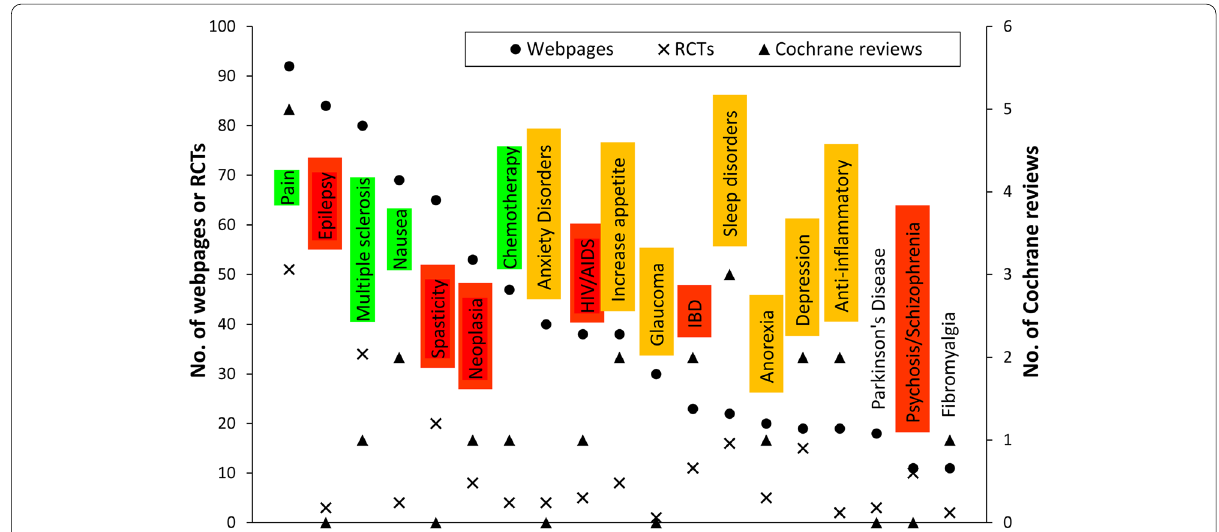
Fig. 2 Therapeutic areas mentioned in the webpage (solid circles) in relation to the number of Cochrane reviews (triangles) and randomized clinical trials, RCTs, (x) in the Cochrane database for that indication. Colors indicate the conclusions on the level of evidence by the National Academies of Sciences, Engineering, and Medicine (NASEM): green, conclusive or substantial; yellow, limited; red, none or insufficient. No color indicates that NASEM did not report a conclusion on that indication. Notes: the conclusive or substantial evidence for pain is limited to chronic pain